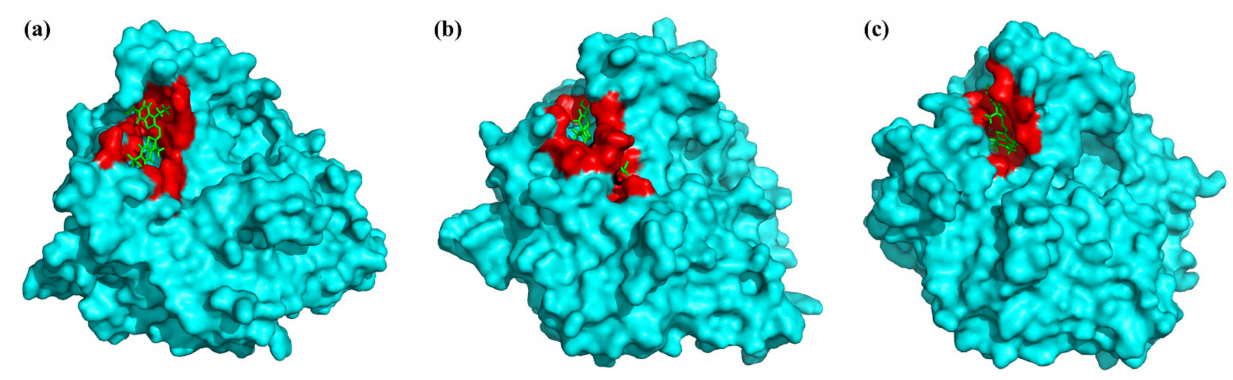
Figure 5. Surface representation and binding modes of the rLAC-ABTS complex. The structures were acquired from cluster analysis of the MD trajectories during 100 ns of simulation at different temperatures, ( a ) 325 K, ( b ) 355 K, and ( c ) 365 K. Surface representation of rLAC (cyan) in complex with ABTS (green) during the initial equilibrated MD trajectory. The substrate-binding pocket is presented as the red